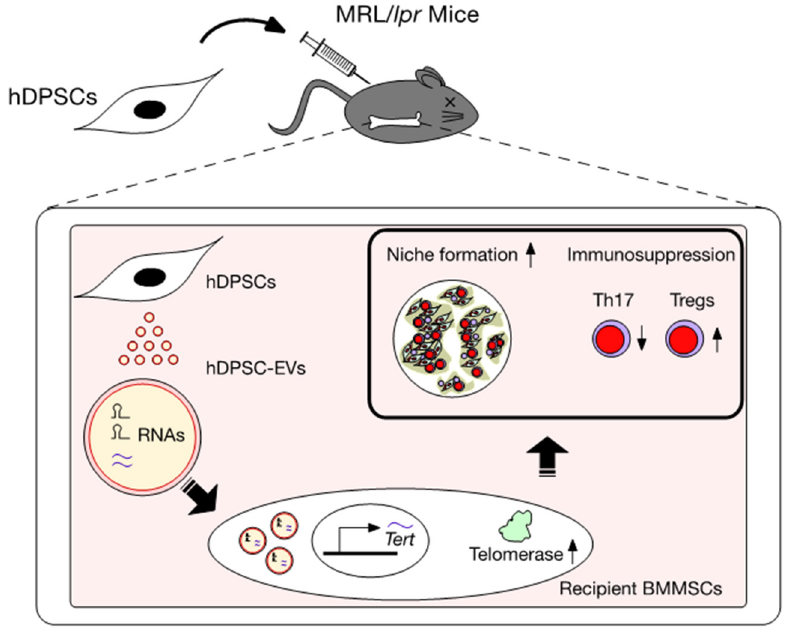
Figure 2. Immunosuppressive mechanism of hDPSC transplantation in systemic lupus erythemato- sus (SLE) model MRL/ lpr mice. Systemically administrated donor hDPSCs release extracellular vesicles, hDPSC-derived Evs (hDPSC-Evs), and are incorporated into recipient bone marrow MSCs of MRL/ lpr mice ( lpr -BMMSCs). The RNA contained within the hDPSC-Evs are transferred into the lpr -BMMSCs to epigenetically enhance telomerase reverse transcriptase gene ( Tert ) expression, improving the SLE disorders of MRL/ lpr mice via recipient BMMSC-mediated niche reconstruction and immunosuppressive function. Th17, interleukin 17 helper T lymphocytes; Treg, regulatory T lymphocytes.